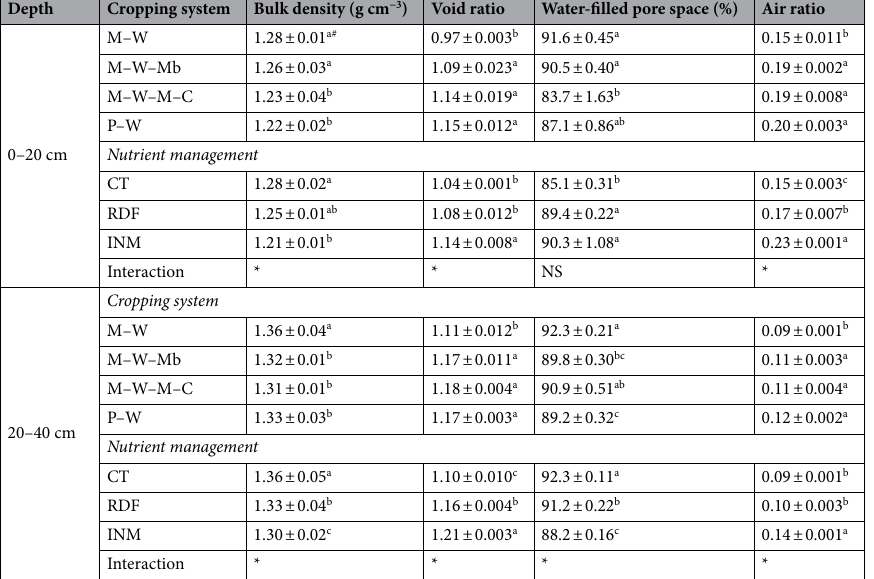
Table 1. Impact of pulses and organic amendments on soil physical indices in long-run. # Lowercase letters (a–c) after values (mean ± standard error) delineates significant difference at p ≤ 0.05 using Tukey’s honest significance test; *denotes interaction is significant; NS = non-significant.